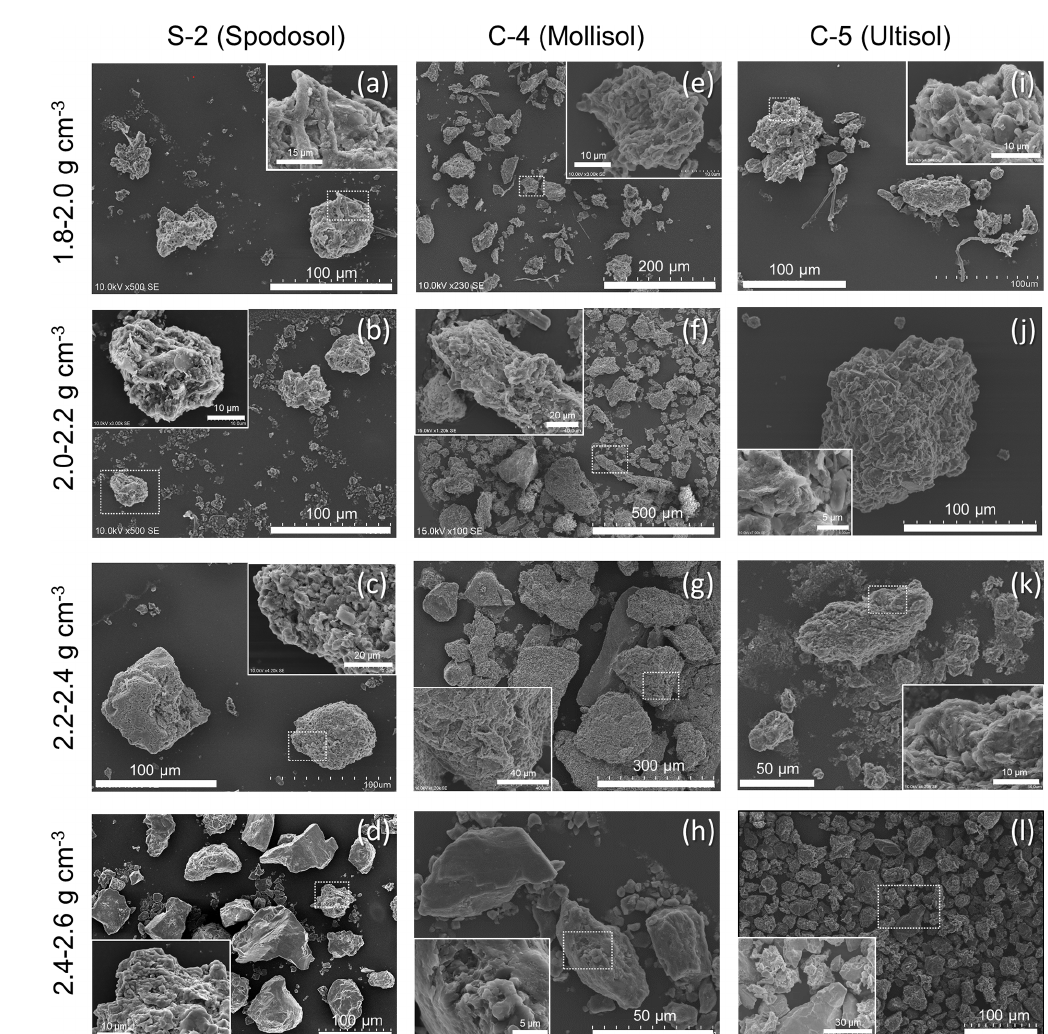
Figure 6. SEM images of three meso-density fractions and the adjacent higher-density fraction from S-2 soil (spodic horizon, a–d ), C-4 soil (mollic horizon, e–h ), and C-5 soil (kaolinitic A horizon, i–l ). The enlarged view of the dotted rectangular section is shown at a corner, showing that the surface of selected particles was often aggregated or coated with finer materials such as clay